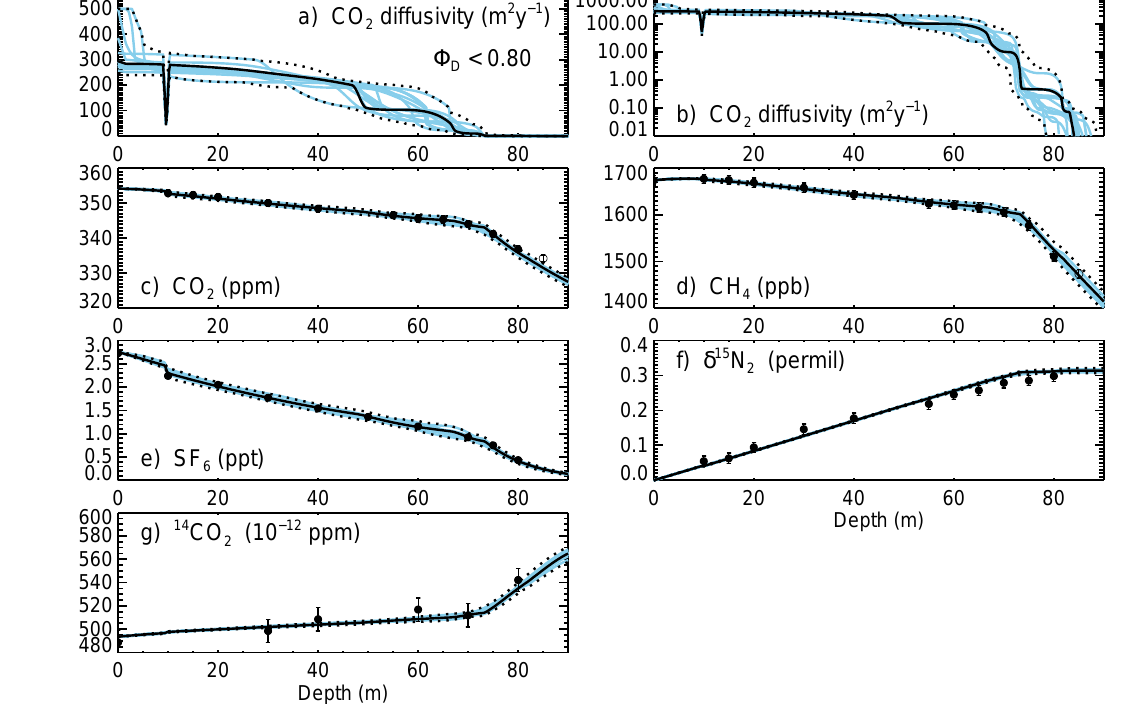
Fig. 9. Diffusivity and tracers at DE08-2 for 8 D < 0 . 8.